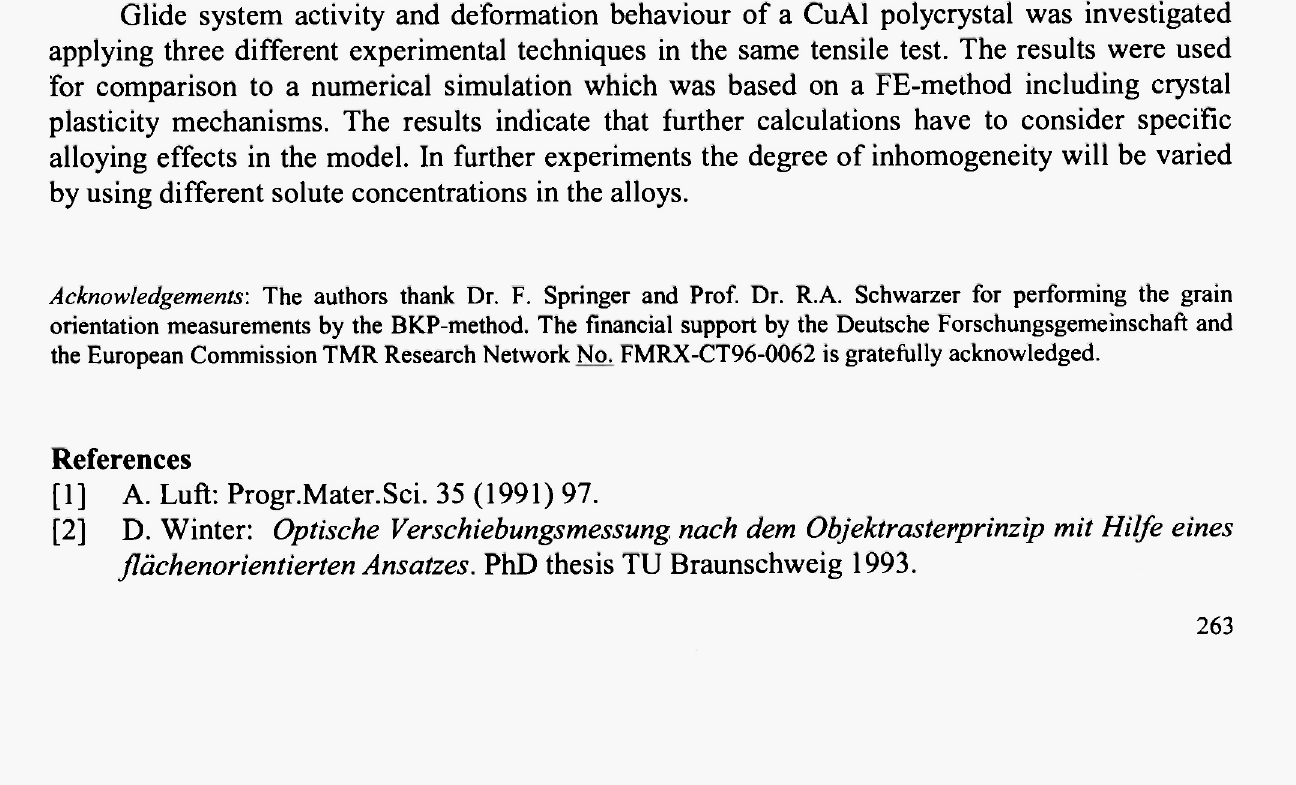
Figure 7: Comparison of measured and simulated stress strain